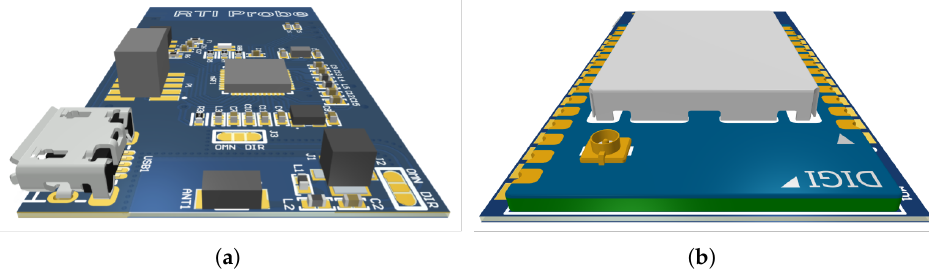
Figure 3. Three-dimensional visualization of the PCB obverse of the tomography radio probe. ( a ) Front side of the PCB. ( b ) Reverse side of the